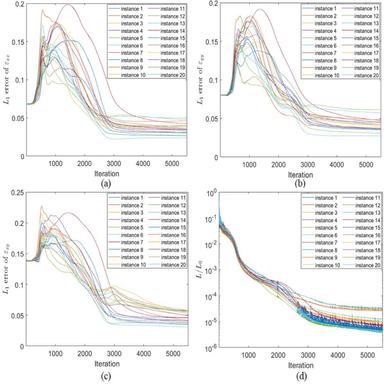
RVE model with eight circular inclusions to examine the capability of RVE-net for knowledge transfer from a trained network.